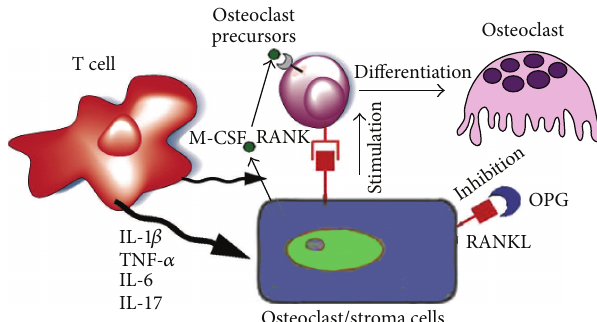
Figure 2: The OPG/RANK/RANKL system and